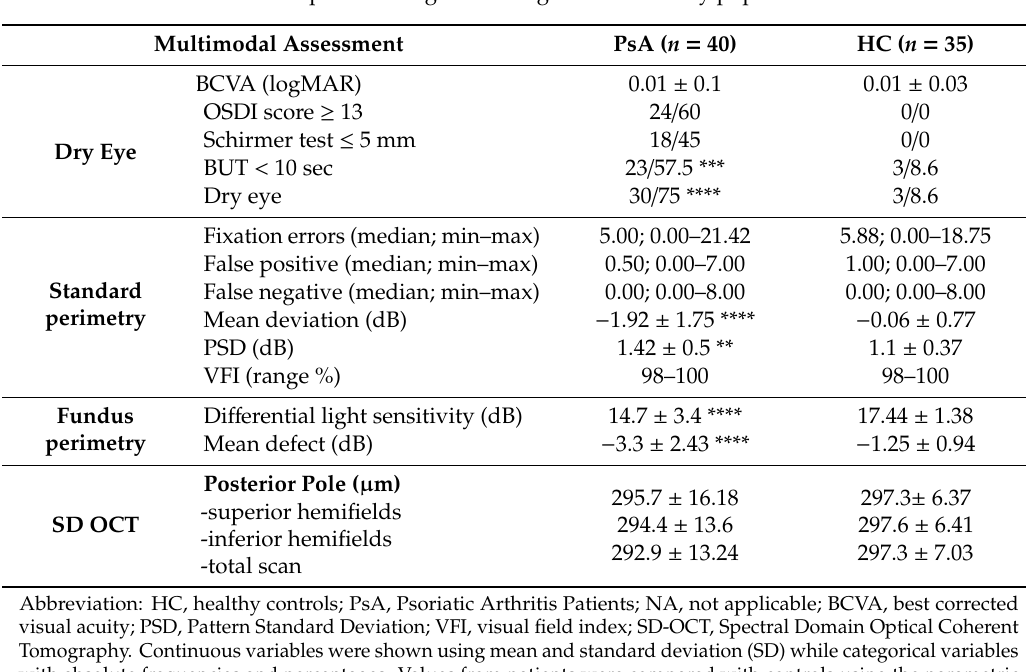
Table 1. Ophthalmological findings from the study population.